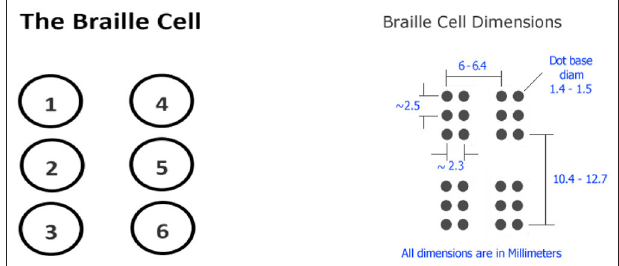
FIGURE 1 | Braille Cell.